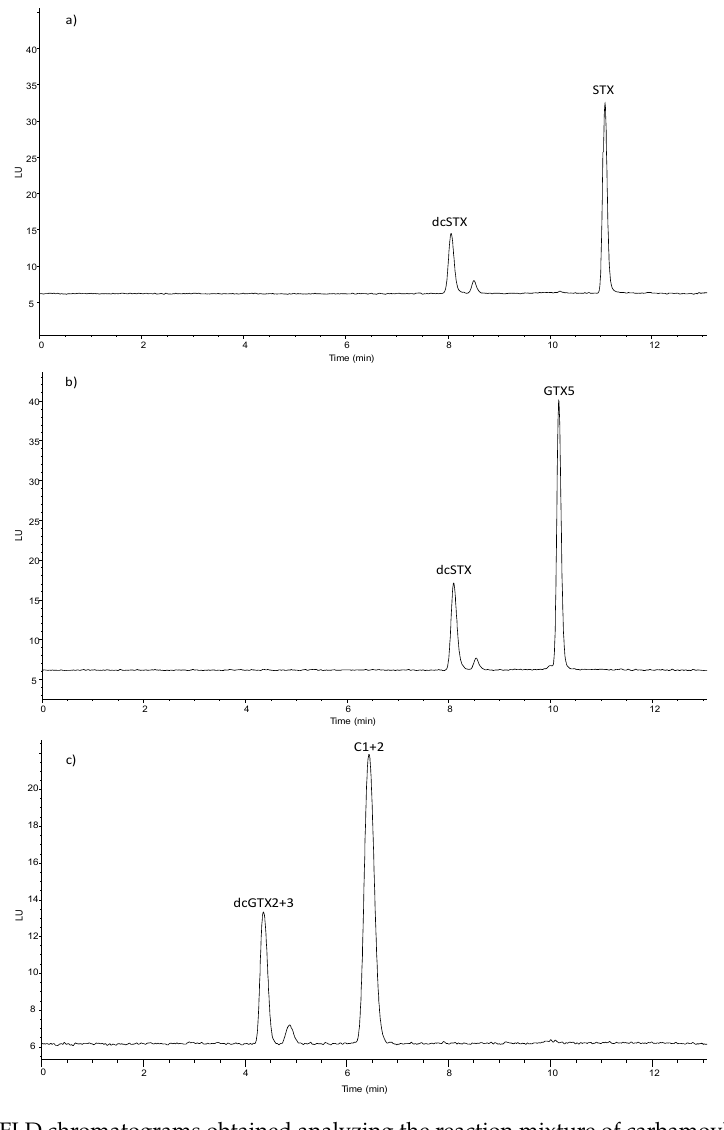
Figure 2. LC-FLD chromatograms obtained analyzing the reaction mixture of carbamoylase with toxin solutions STX ( a ), GTX5 ( b ) and C1+2 ( c ).